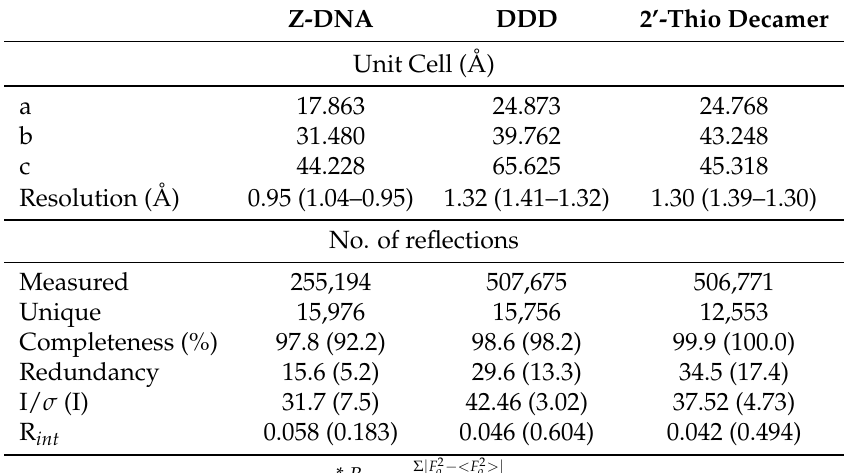
Table 1. Data collection statistics for Z-DNA, Drew–Dickerson DNA dodecamer (DDD) and 2’-thio decamer.